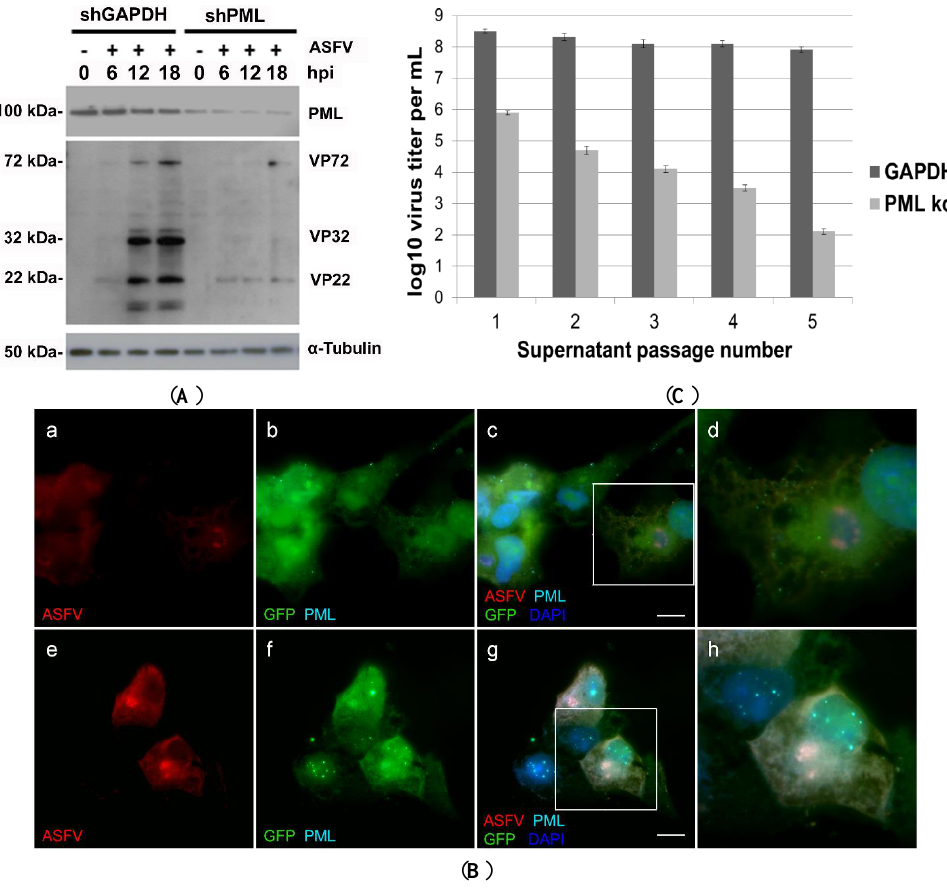
Figure 3. PML has a proviral role in ASFV infection. ( A ) Whole cell extracts were collected from Vero-shRNA-PML and Vero-shRNA-GAPDH cells, non-infected and infected with ASFV Ba71V isolate (MOI of 1) at 6, 12 and 18 hpi. In Vero-shRNA-PML cells, expression levels of a ≈22 kDa viral protein remain residual throughout infection, whereas in Vero-shRNA-GAPDH cells (control) this viral protein showed increasing levels. In addition, other structural viral proteins (≈32 kDa and ≈72 kDa) in ASFV-infected PML knockdown cells did not present the expression levels detected in infected shGAPDH cells, even at late times of infection. Overall, viral protein synthesis is diminished in Vero-shRNA-PML knockdown cells. As expected, mock-infected cells (0 hpi), showed no viral protein expression. α-Tubulin was used as loading control. Molecular weights (kDa) of evaluated proteins are indicated on the left of immunoblot images; ( B ) PML knockdown cells display lower intensity viral proteins staining and aberrant ASFV factories.